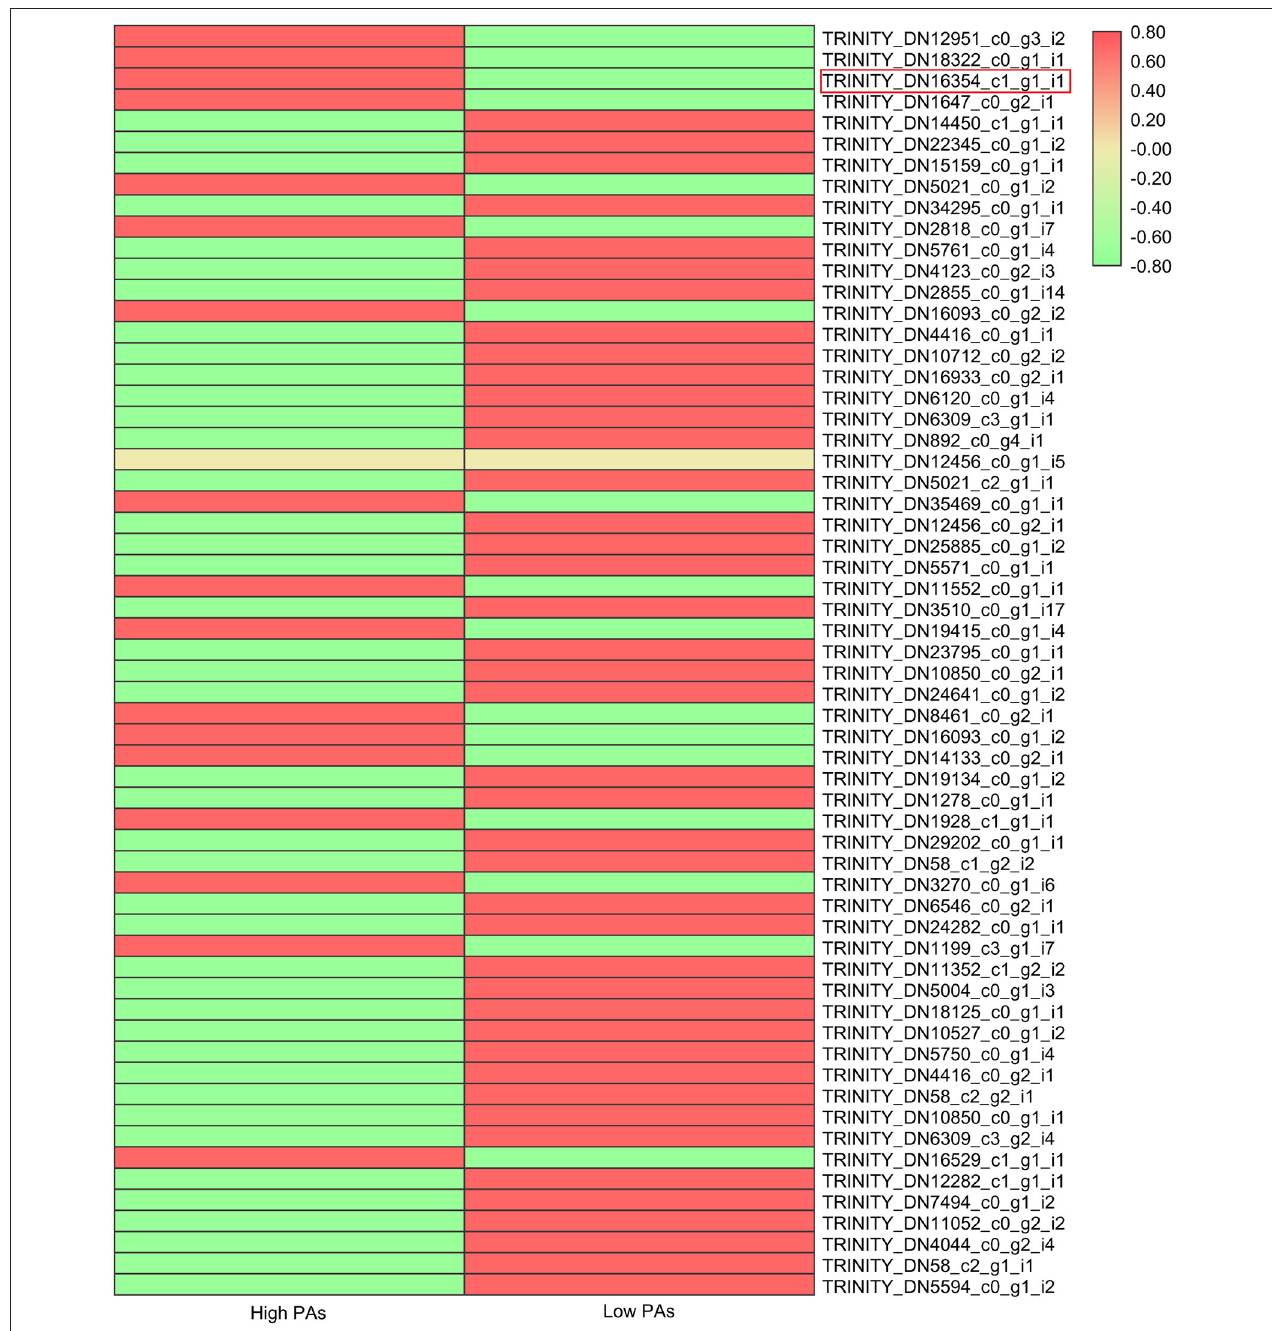
FIGURE 4 | Expression levels of MYB transcription factor genes in two sainfoin samples. The heat map was drawn by TBtools with the Log 2 FPKM values of 60 MYBs in O. viciifolia with high PAs and low PAs. Different colors depict different expression levels, red means higher expression levels, and green means lower expression levels. Red box represents the MYB named as OvMYBPA2 that was subsequently cloned and functionally validated in this